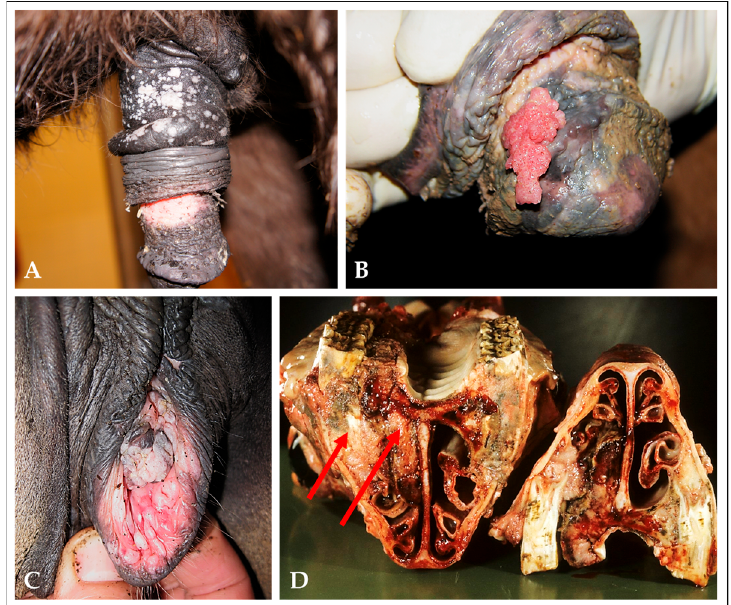
Figure 2. Squamous cell carcinomas (SCCs) in the horse. ( A ) and ( B ): equine-penile-SCC precursor lesions: whitish, benign plaques ( A ) and papillomatous lesion ( B ). ( C ): equine vulvar carcinoma in situ (CIS). ( D ): equine SCC affecting the right maxillary sinus and ventral nasal meatus (red arrows); (this photograph was kindly provided by Dr Andrea